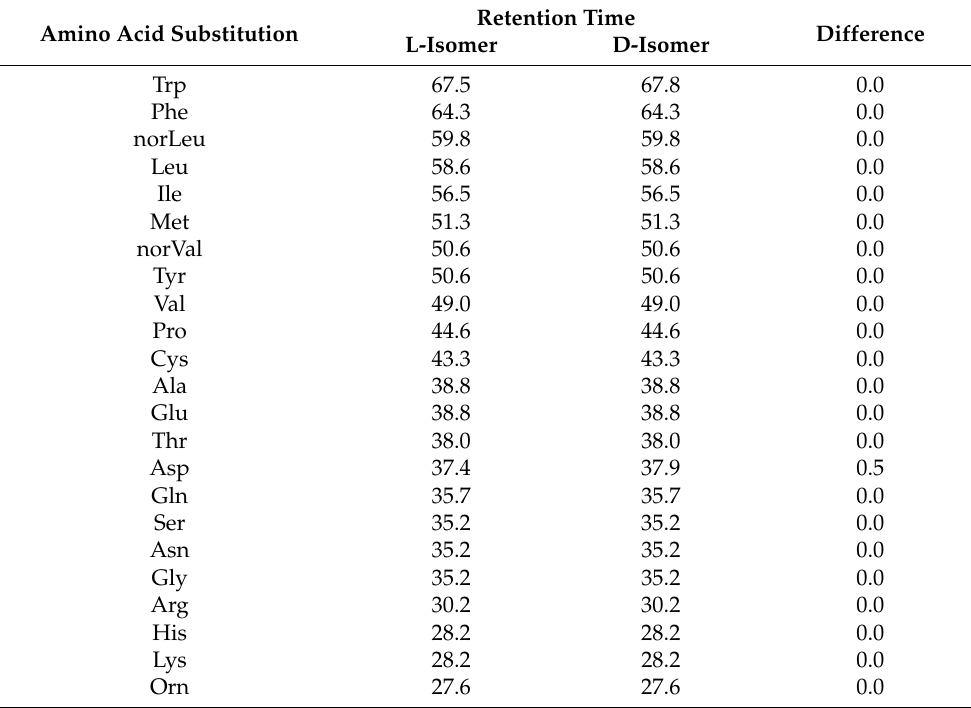
Table 7. Comparison between the retention times of (L and D)-peptides, absence of the nearest group effect (Ac − XGAKGAGVGL − amide)